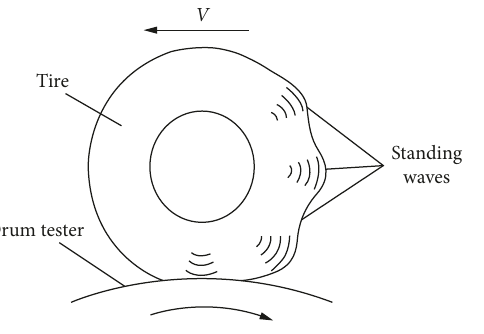
Figure 1: Tire standing waves.